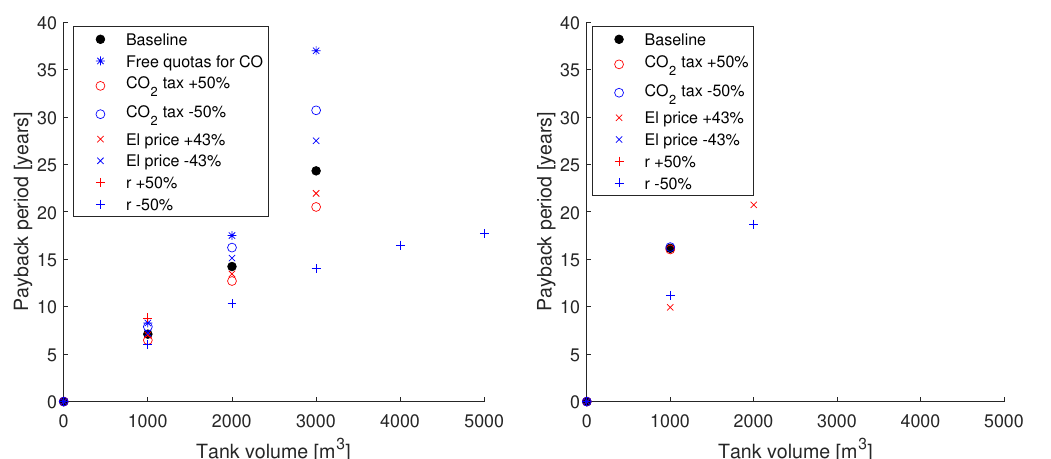
Figure 8. Payback period for Scenarios 1 ( left ) and 2 ( right ), including variation in selected parameters.